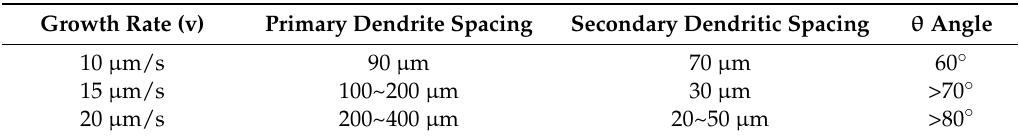
Figure 3. Morphologies of the initially solidified dendrite of the quenched zone of the DS Ti-44Al-9Nb-1Cr-0.2W-0.2Y alloy at different growth rates: ( a ) V = 10 μ m/s; ( b ) V = 15 μ m /s; and ( c ) V = 20 μ m/s (D: primary dendrite growth direction; S: secondary dendrite growth direction; θ : The angle between the primary dendrite and secondary dendrite growth direction). Table 2. Dendritic growth morphology parameters.